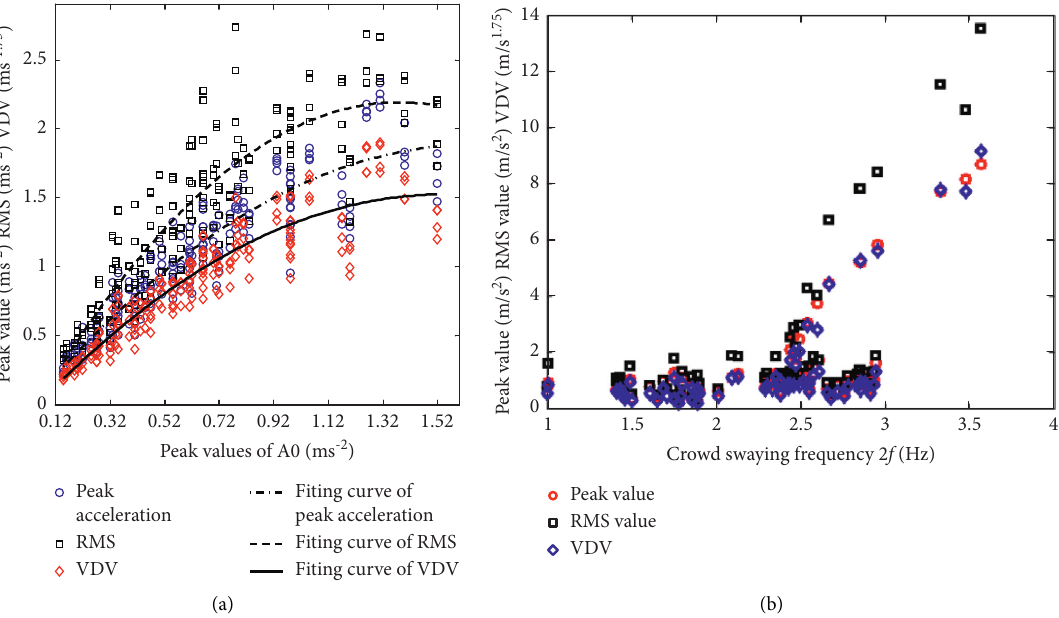
Figure 6: The relationship of input conditions and output accelerations: peak values, RMS values, and VDV. (a) Shaking table experiment results; (b) human-induced vibration experiment